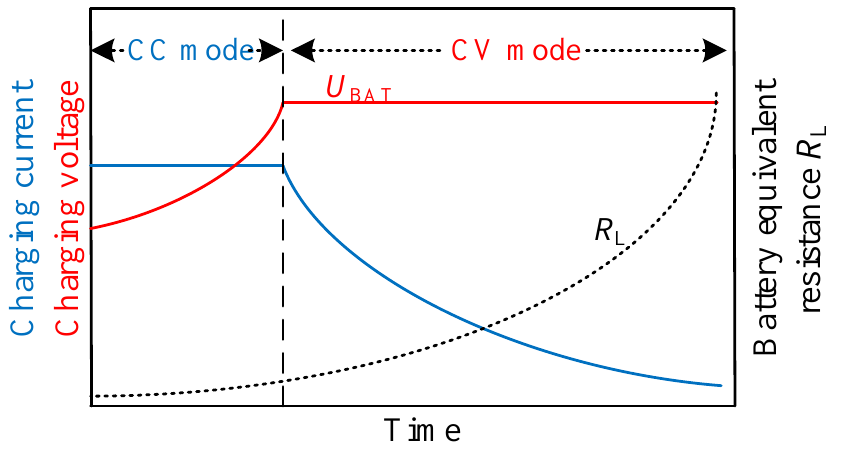
Figure 1. Typical charging profile of the battery.